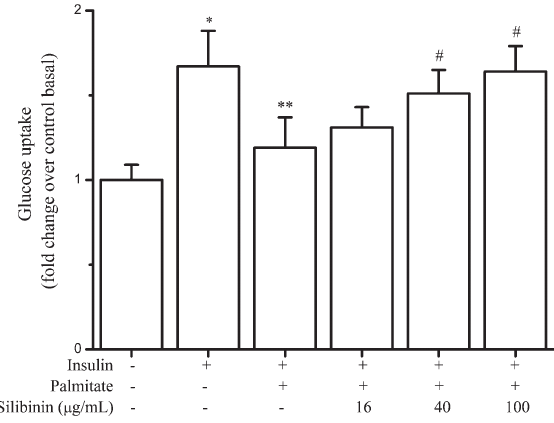
Figure 2. Effect of silibinin on insulin-stimulated glucose uptake in palmitate-treated C2C12 myotubes. C2C12 myotubes were incubated with palmitate (0.75 mM) or silibinin ++ palmitate, then stimulated with insulin (100 nM), followed by assay for 2-NBDG uptake as described in Methods. Data are reported as means±SD of 4 determinations. *P , 0.05, compared to control